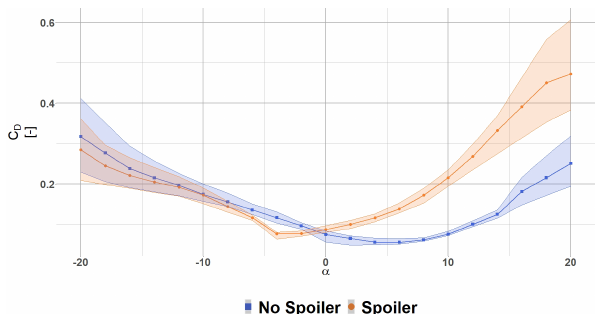
Figure 16. Drag coefficient polar for the radial position R6 ( r 13%). The blue square (blue (cid:4) ) shows the C D for the no spoiler case, and the orange dot (orange • ) shows the C D for the spoiler